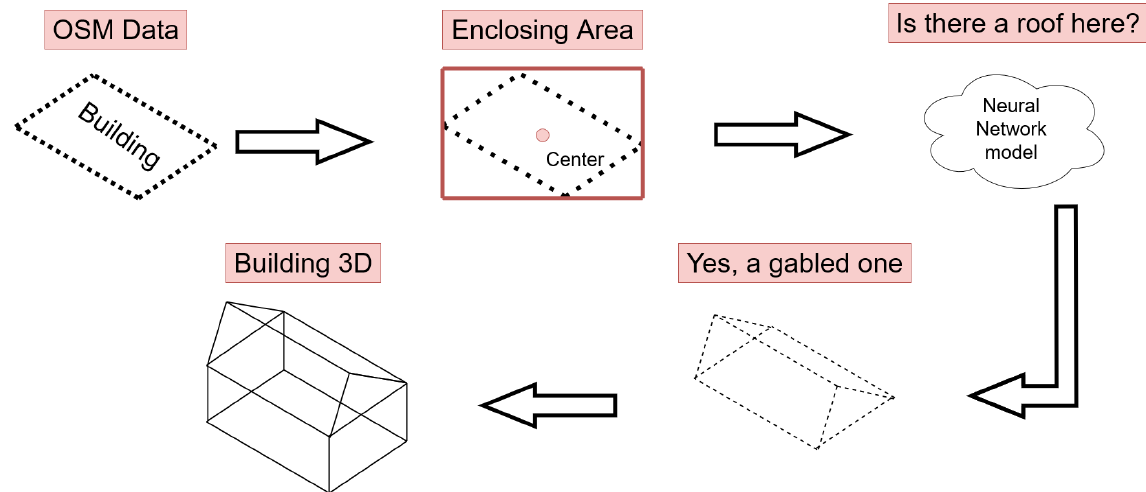
Figure 6. Process of adding a roof to a building using the neural